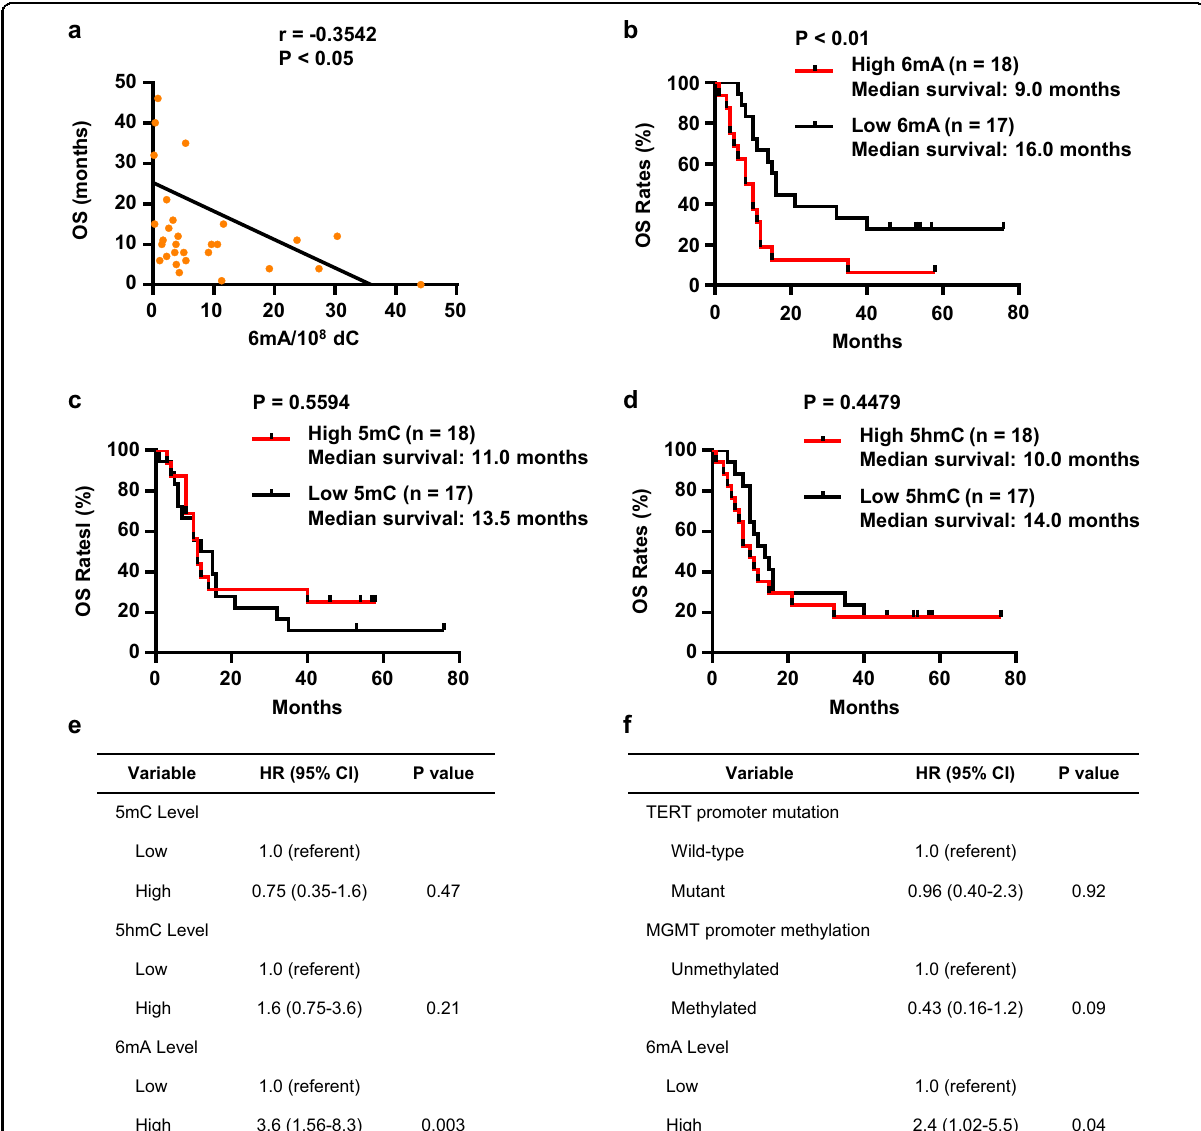
Fig. 5 The level of misincorporated DNA 6mA is correlated with overall survival rates in human glioblastomas. a Pearson correlations between 6mA level and overall survival time of GBM patients ( n = 35). b Kaplan – Meier curve of GBM patients survival according to 6mA levels in GBM tissues. Patients were strati fi ed into the “ high level 6mA ” group ( n = 18) and the “ low level 6mA ” group ( n = 17). c , d Kaplan – Meier curve of GBM patients survival according to 5mC ( c ) or 5hmC ( d ) levels in GBM tissues. Patients were strati fi ed into the “ high level 5mC/5hmC ” group ( n = 18) and the “ low level 5mC/5hmC ” group ( n = 17). e Multivariate Cox proportional hazards ratios for survival based on 6mA level adjusted for 5mC and 5hmC of patients. f Multivariate Cox proportional hazards ratios for survival based on 6mA level adjusted for TERT promoter mutation and MGMT promoter methylation of patients. a Statistical signi fi cance was determined by Student ’ s unpaired t -test. b – d Signi fi cance was determined by log-rank